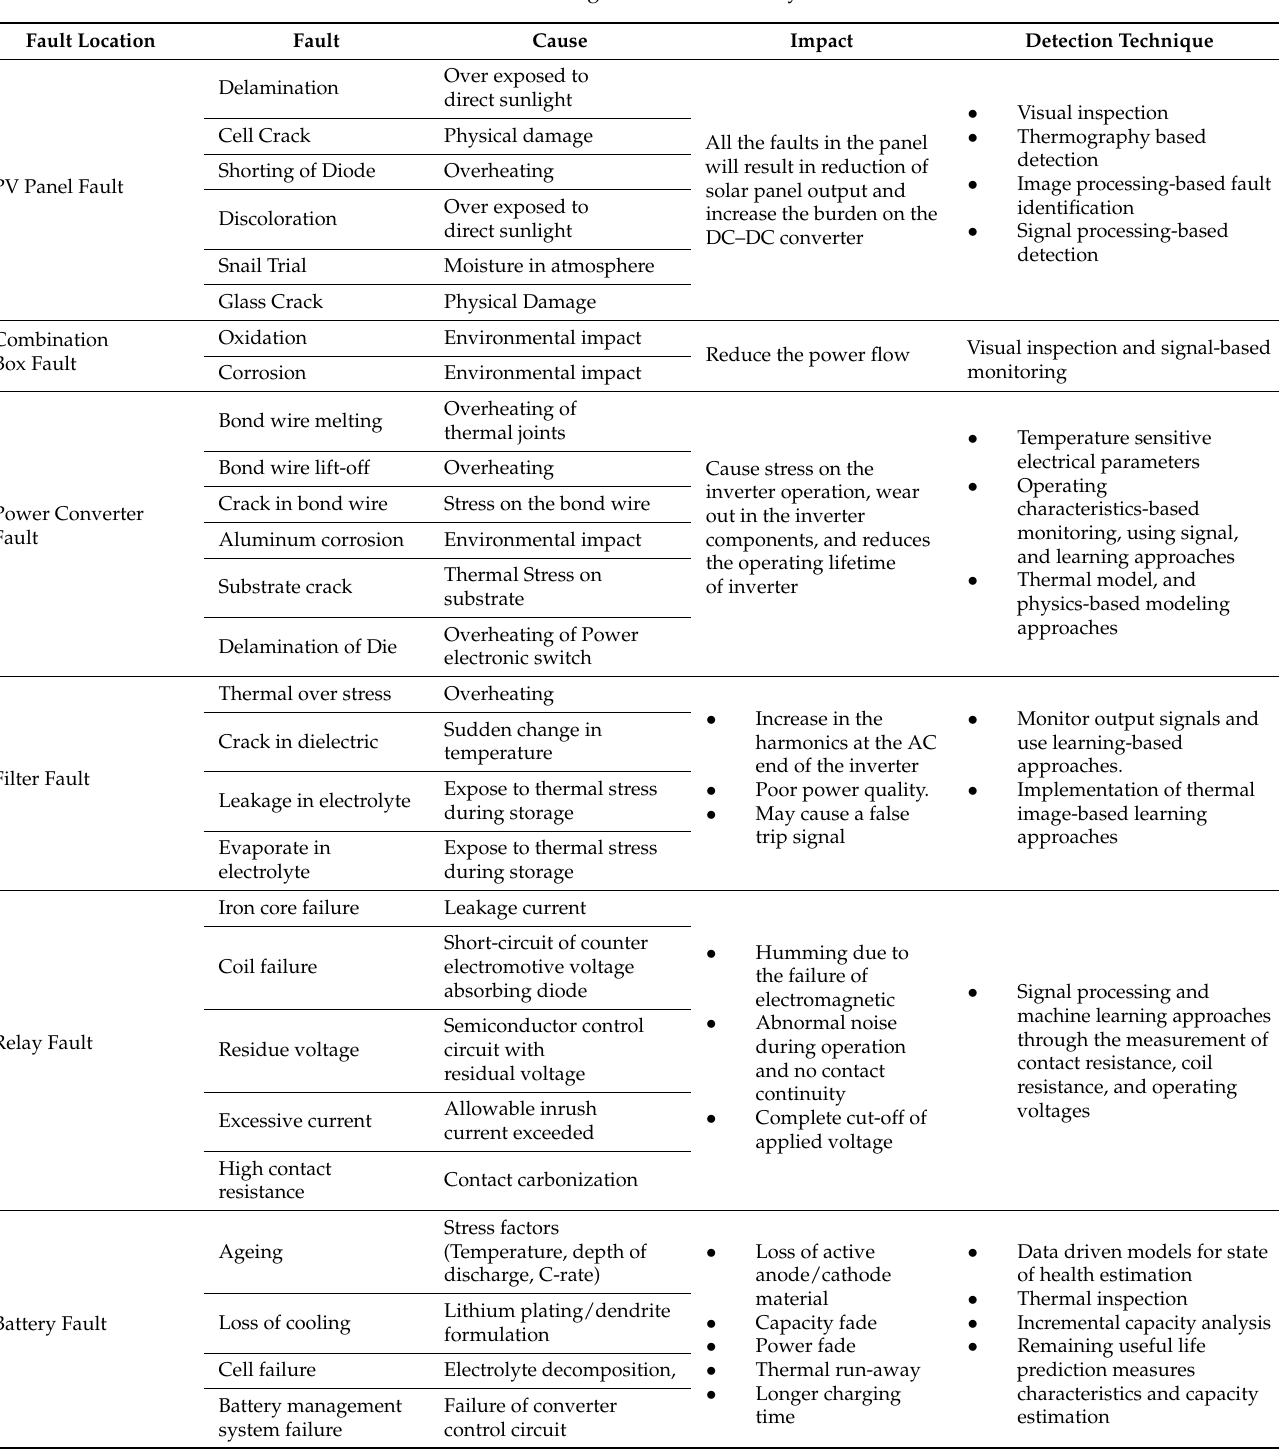
Table 9. Faults in grid-connected PV